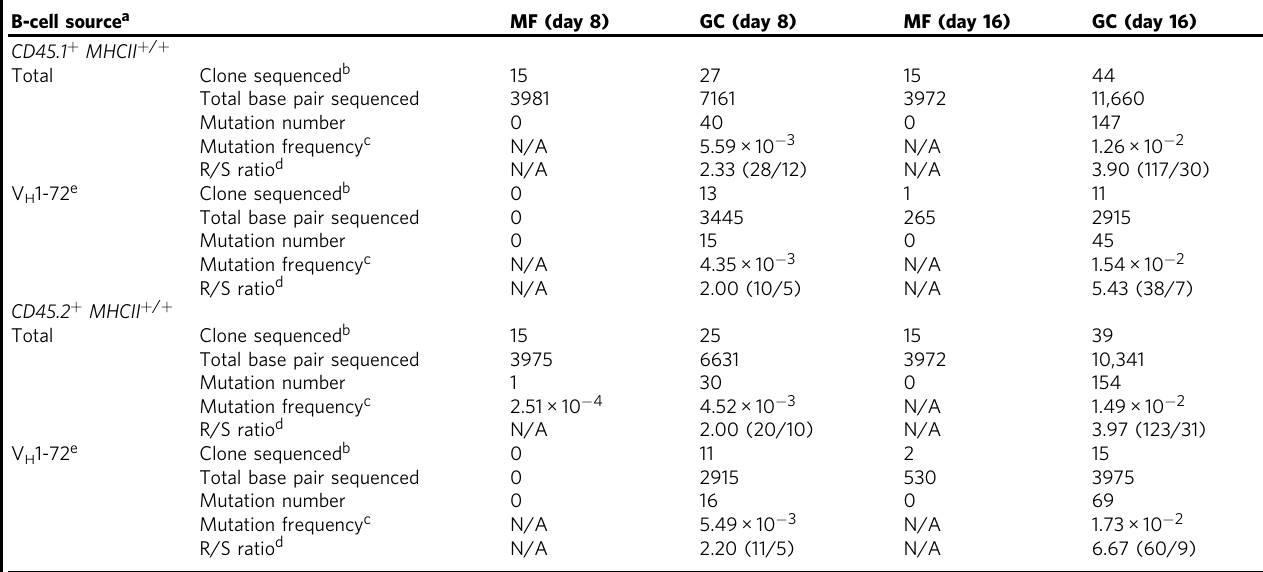
Table 2 V H gene sequence summary of single B-cell Nojima cultures B-cell source a